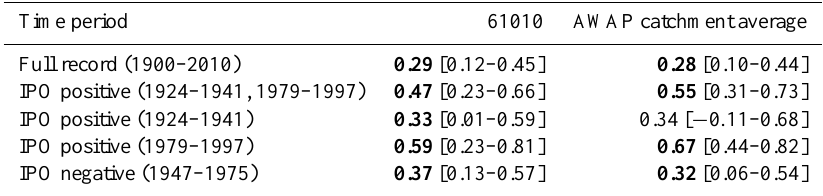
Table 1. Pearson correlation values between LD SSS and 12-month average (October–September) rainfall recorded at gauge 61010 and the AWAP WR catchment average for the 1900–2010 period and IPO phases. Bootstrap 95% confidence intervals are also indicated (Mudelsee, 2003). Bold values are significant at